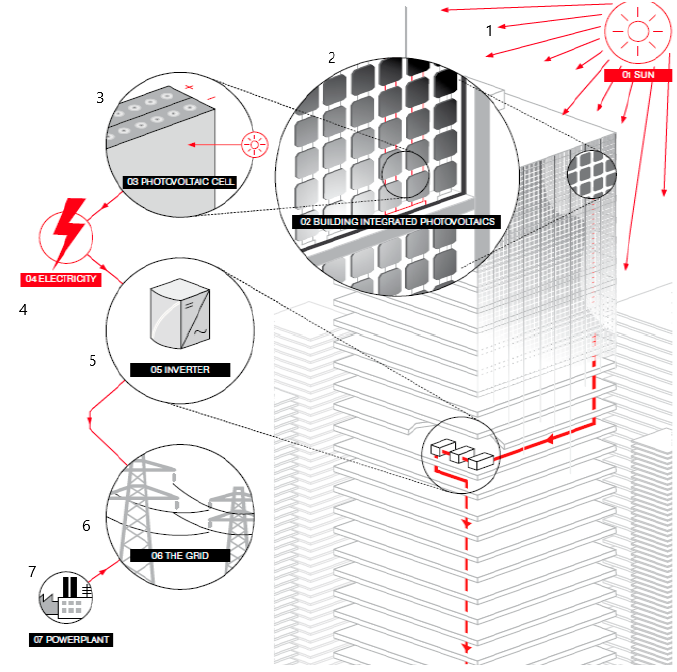
Figure 1. Description of the solar energy process. Legend to Figure 1: 1-Sun; 2-Building Integrated Photovoltaics; 3-Photovoltaic Cell; 4-Electricity;